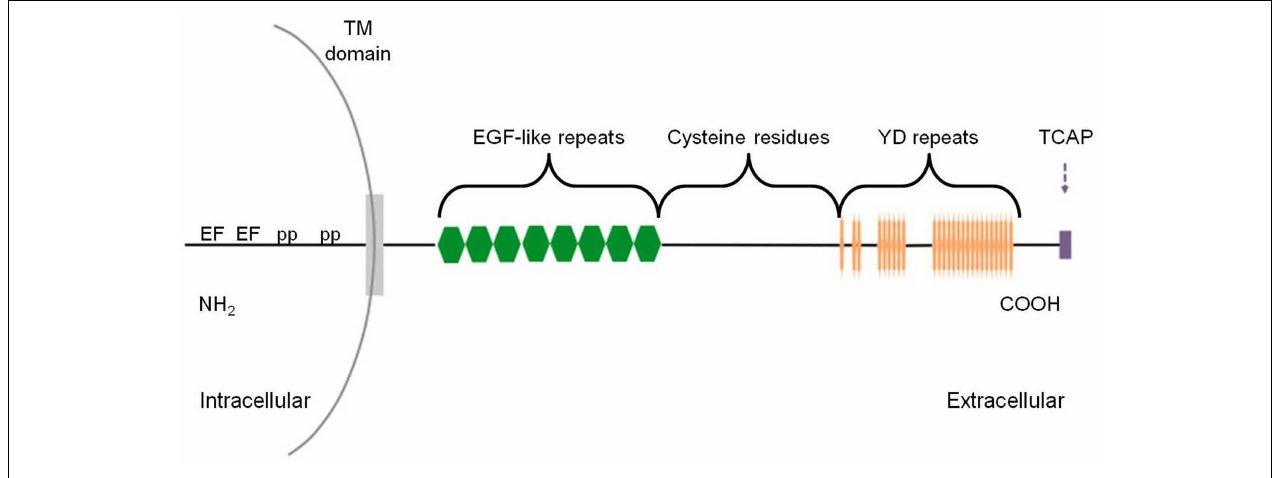
FIGURE 1 | Schematic of teneurin-TCAP protein structure. The intracellular amino terminus contains polyproline (pp) sites and EF-hand-like Ca 2 + binding motifs (EF). The extracellular domain is composed of eight